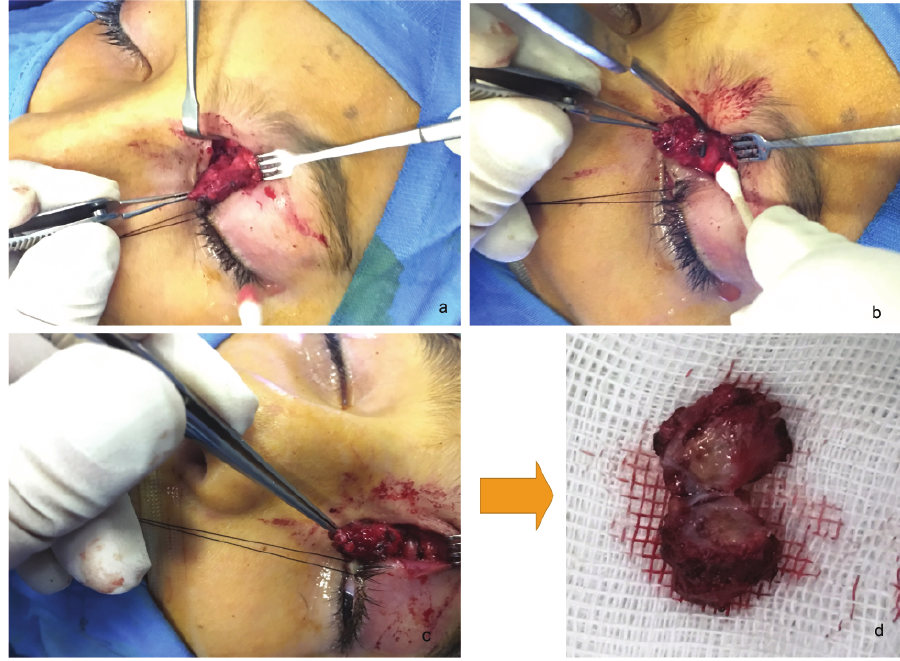
Figure 3. (a) Intraoperative view of the lesion, located between superior oblique and superior rectus muscles. (b) Meticulous dissection of the lesion from superior oblique muscle and trochlea. (c) Successful and complete separation of the lesion from superior oblique muscle. Separating from extensive adhesion and partly implementing into medial rectus muscle. (d) Bisection of the lesion after complete removal. Contents of the cyst, including a jelly like material in the core and thread-like object putting on the side.